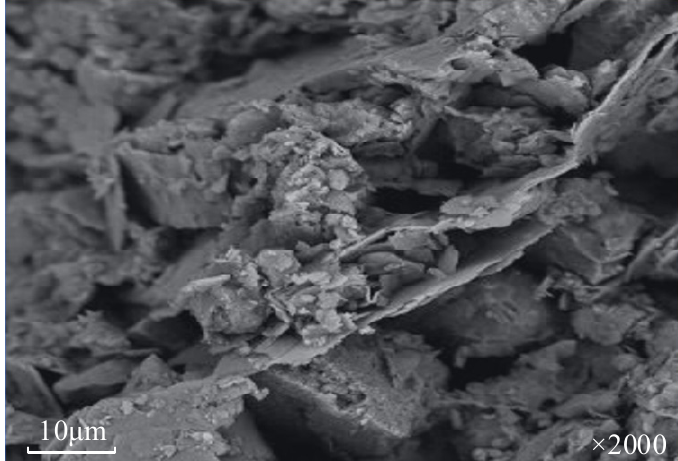
Figure 2. Microstructure of undisturbed Yangtze River floodplain facies soft soil.